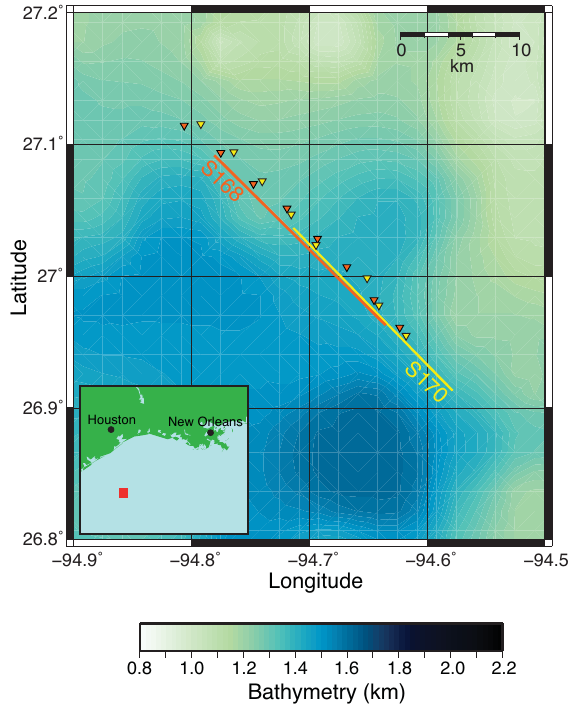
Fig. 1. Location map. Bathymetry has been interpolated from a 1 0 grid (Smith and Sandwell, 1997) to 0.5 0 grid spacing. Orange and yellow lines show locations of the CMP swaths; triangles show locations of the XBT